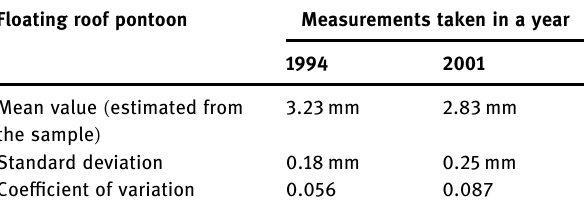
Figure 15: The progress of corrosion during the use of tank number 1 inventoried by the authors for the third coating sheet ( maximum, average, and minimum values are compared here for illustrative purposes ) .